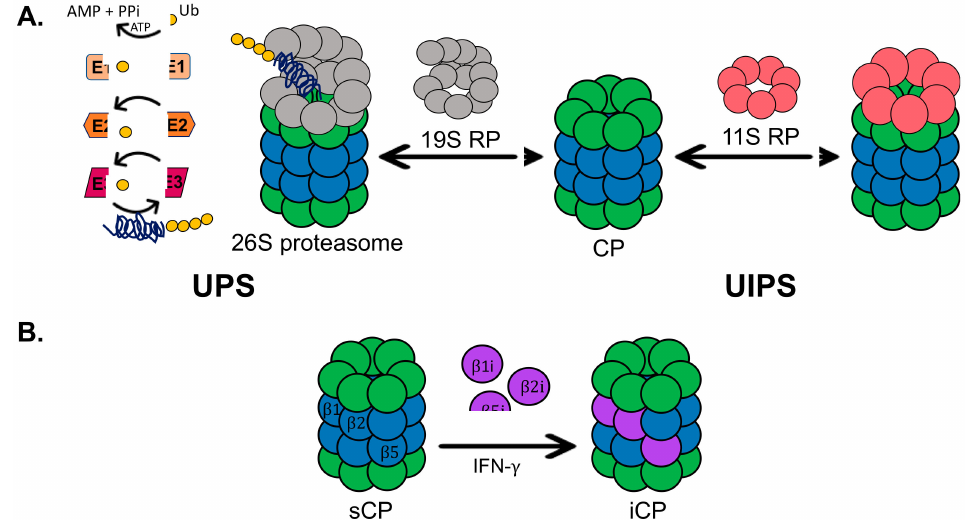
Figure 1. ( A ) Overview of the ubiquitin-proteasome system (UPS) and the ubiquitin-independent proteasome system (UIPS). The UPS utilizes a set of E-ligases to polyubiquitinate protein substrates for recognition and degradation by the 26S proteasome. The UIPS employs the 20S core particles (20S CP), which can be capped or uncapped by the 11S regulatory particle (11S RP), to degrade oxidatively damaged and intrinsically disordered proteins. ( B ) In the presence of pro-inflammatory signals, such as interferon-gamma (IFN- γ ), the catalytic subunits of the standard 20S CP (sCP) can become exchanged for the catalytic subunits of the immunoproteasome